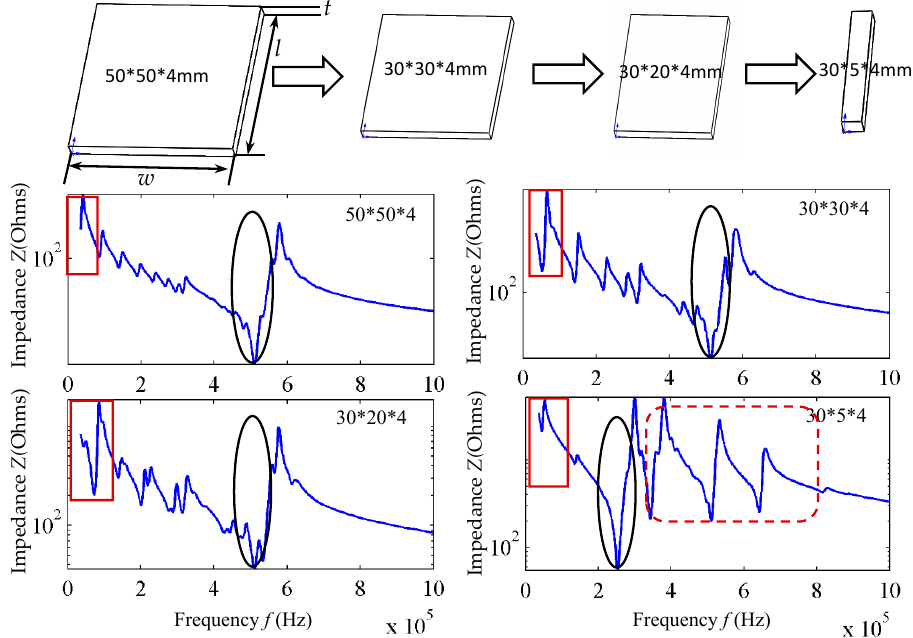
Figure 2. Analysis of resonant frequency of piezoelectric ceramics with dimension parameter change.